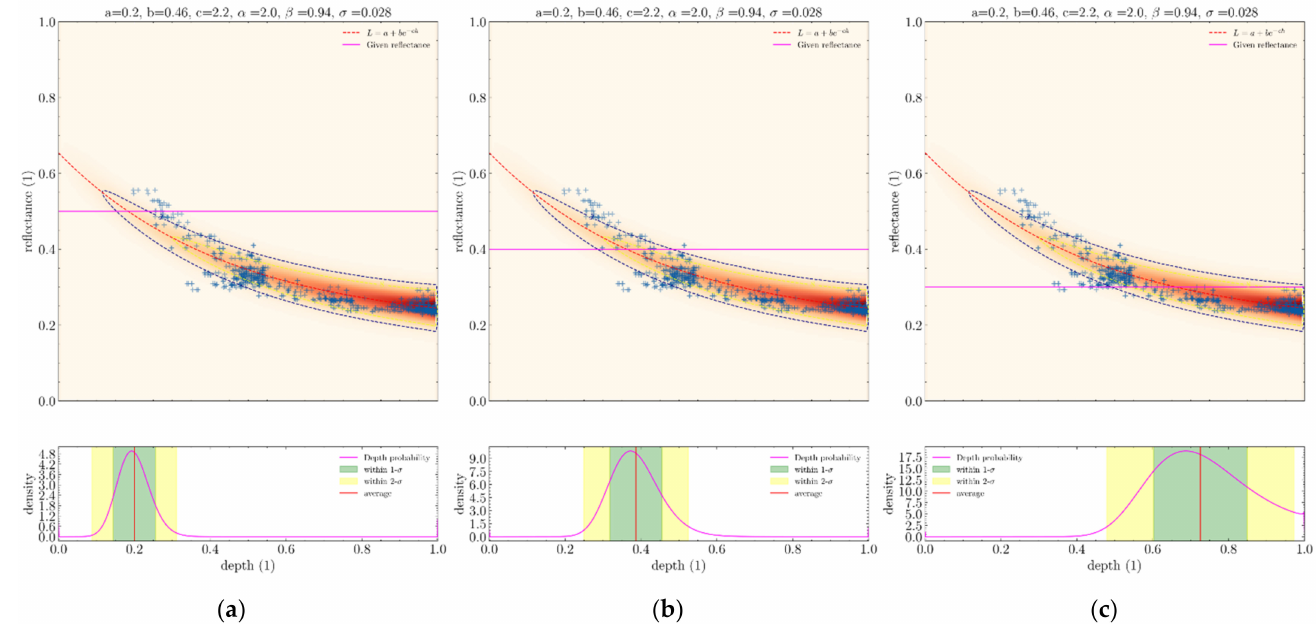
Figure 16. Inferring depth for a given input reflectance (horizontal magenta line) for a single BNP distribution trained on a few sample points (blue crosses). Three cases shown here. ( a ) high reflectance. ( b ) average reflectance. ( c ) low reflectance. The range of possible depth values for the given reflectance sample can be seen below in the form of an histogram with uncertainty ranges